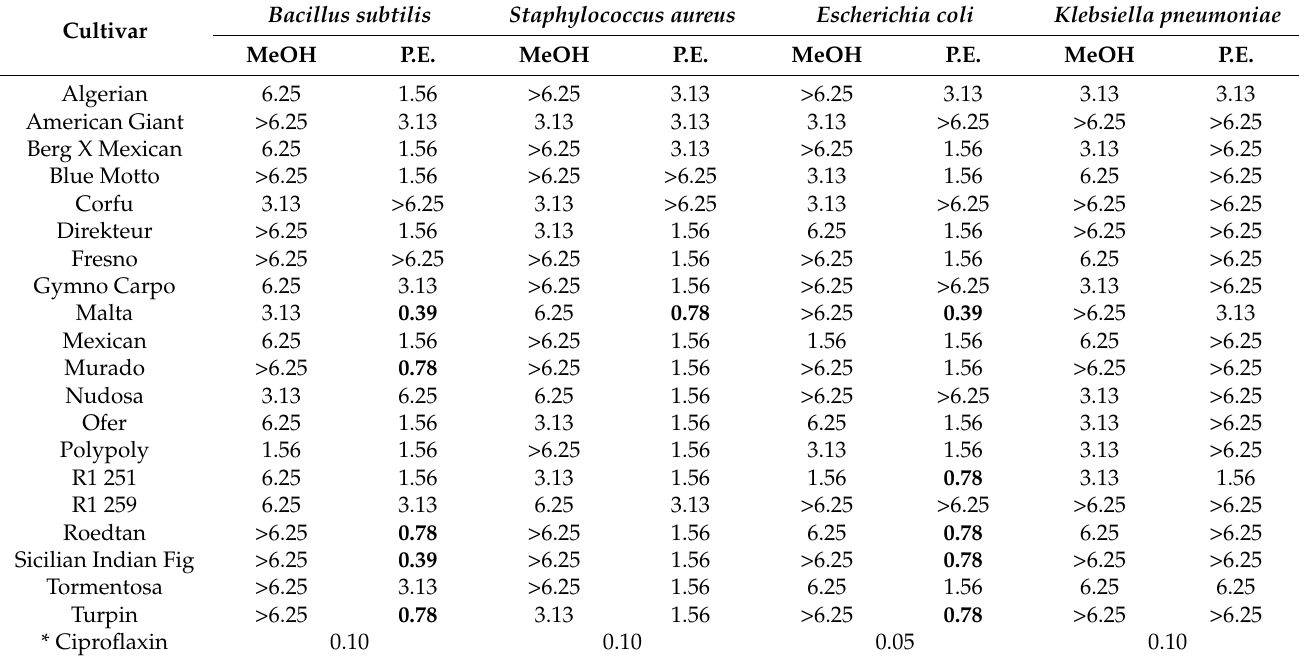
Table 4. Antibacterial activity (minimum inhibitory concentration; mg/mL) of cladodes from 20 selected spineless cactus pear